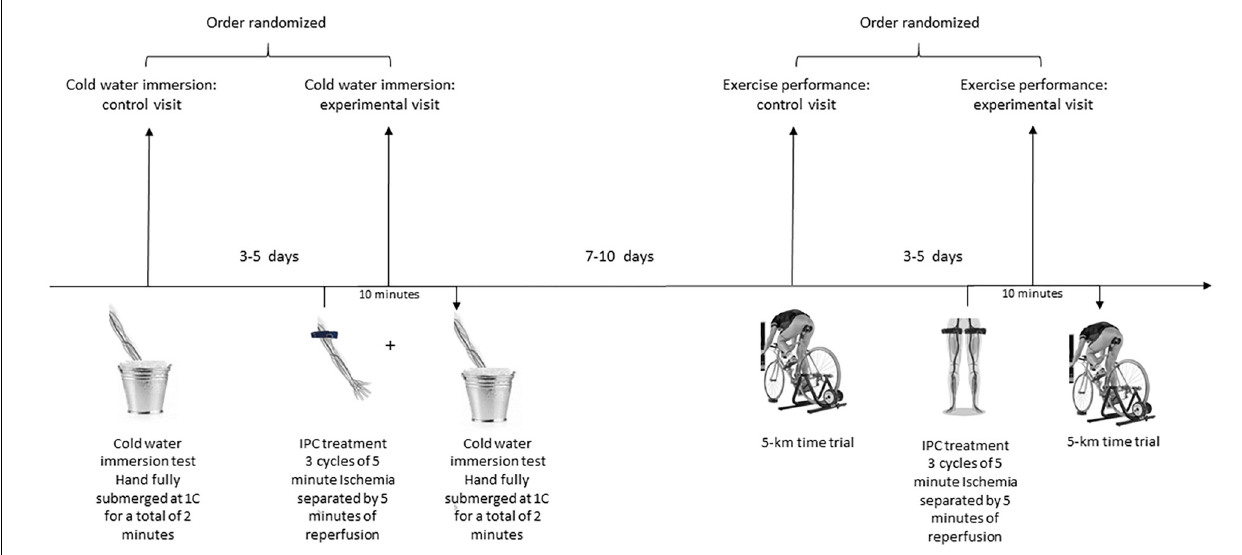
FIGURE 1 | Schematic Overview of the experimental design. Each participant underwent two separate cold-water immersion tests: with preceding unilateral IPC administration to the left arm (experimental visit) and without (control visit). Each participant also underwent two 5-km time trials: with preceding bilateral IPC administration to the legs (experimental visit) and without (control